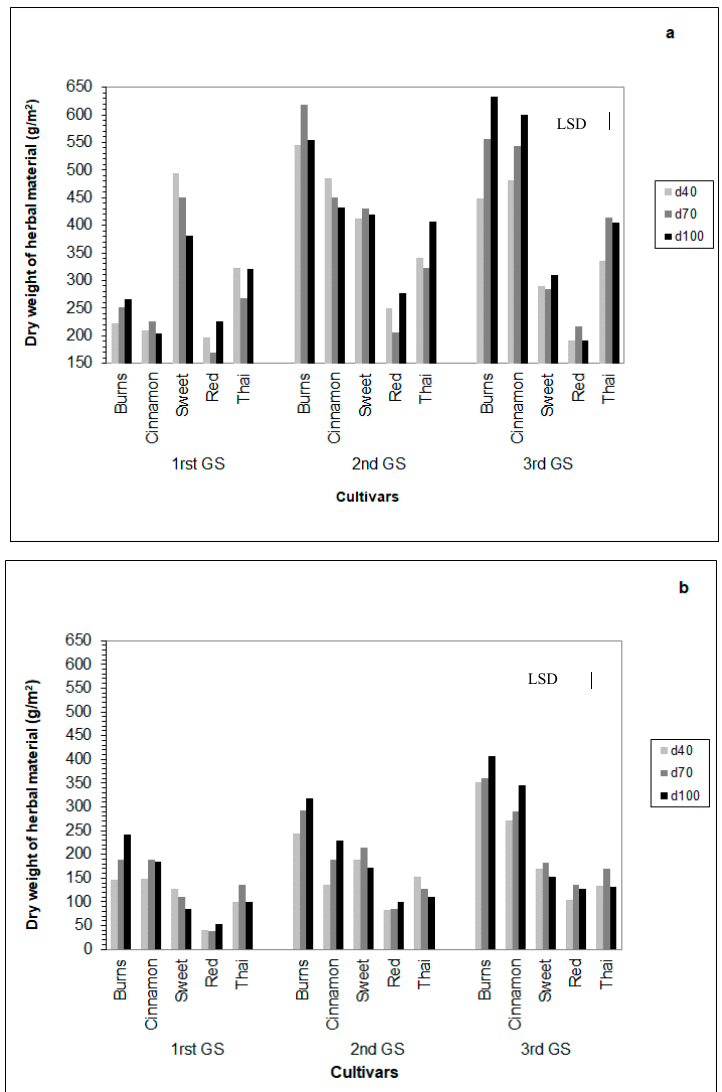
Figure 1. Dry weight of herbal material of the five basil cultivars during the three growing stages (GS) (where 1 is for the initiation of flowering, 2 is for the full bloom, 3 is the end of flowering) at the three irrigation levels (d 40 , d 70 and d 100 ) for the two growing seasons 2015 ( a ) and 2016 ( b ). Data presented are mean values; vertical bar corresponds to the least significant difference (LSD= 85.89).